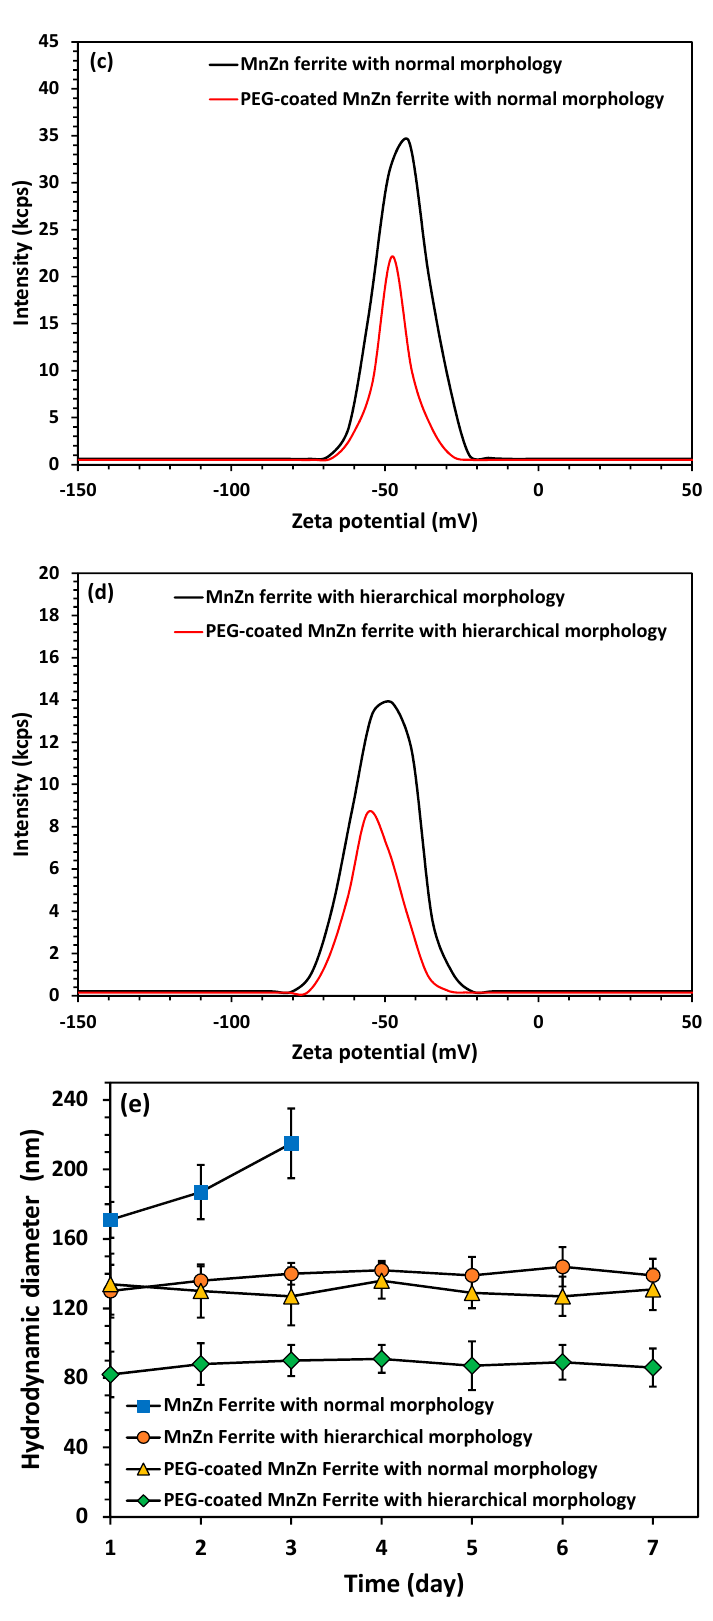
Figure 7. ( a , b ) Graphs of DLS, ( c , d ) graphs of zeta potential analyses, and ( e ) results of colloidal stability test for suspensions containing PEG-coated and uncoated MnZn ferrite nanoparticles with di ff erent morphologies. Error bars are standard deviation (n = 3).